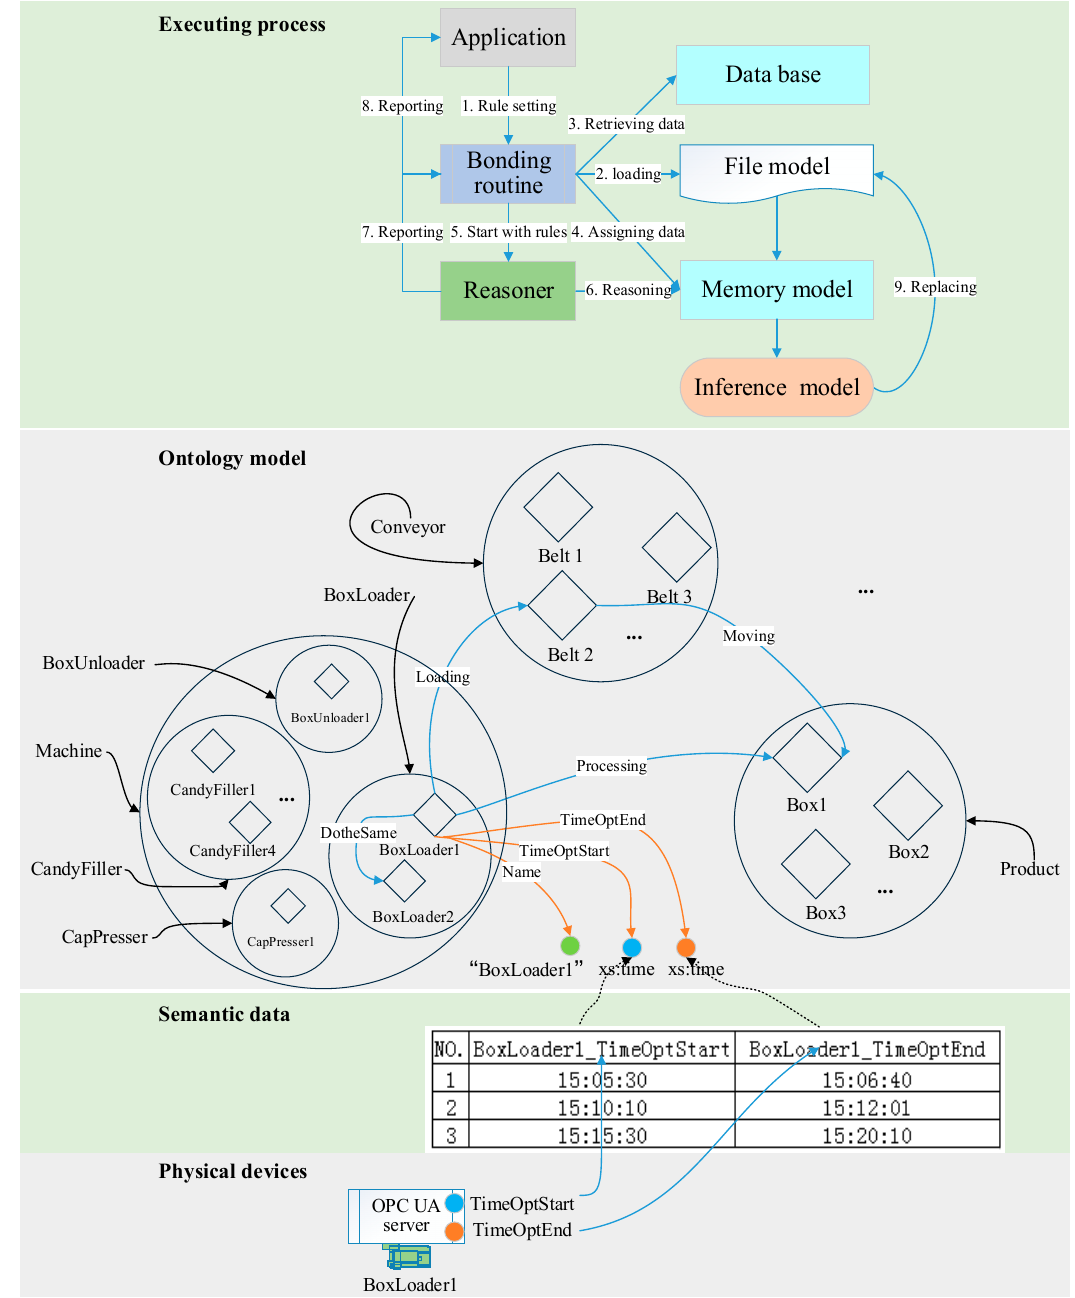
Figure 4. Illustration of integration of knowledge reasoning and semantic data.